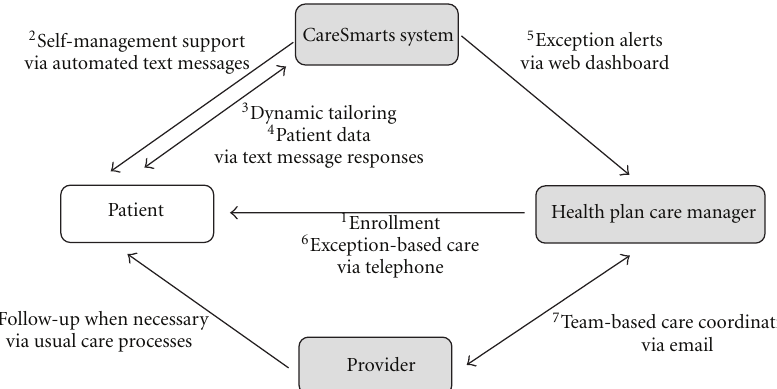
Figure 1: Conceptual representation of the text message-based chronic care program. 1 Health plan care managers enroll eligible member with type 1 or type 2 diabetes over the phone. 2 Patient receives self-management support via automated text messages and respond to